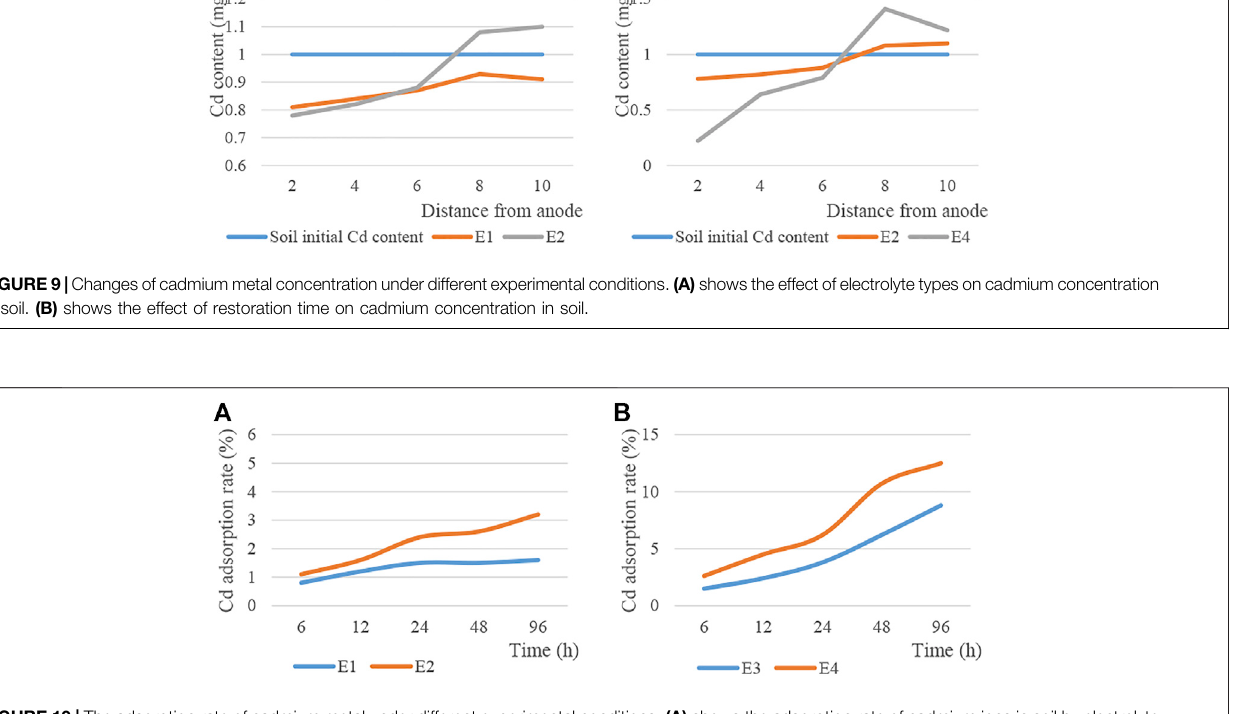
FIGURE 10 | The adsorption rate of cadmium metal under different experimental conditions. (A) shows the adsorption rate of cadmium ions in soil by electrolyte types. (B) shows the adsorption rate of cadmium ions in soil by voltage.